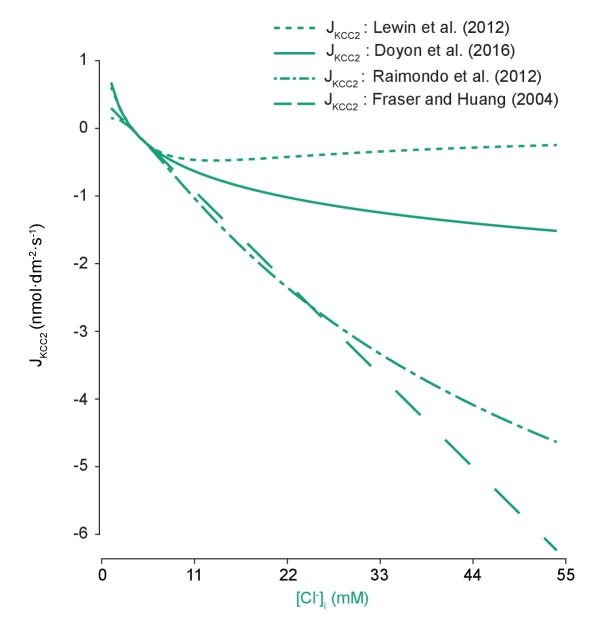
Models of KCC2 have different kinetic properties.The pump rate velocity for different models of KCC2 were compared for differing intracellular chloride concentration. The equation employed in our model was based on Doyon et al. (2016) (solid line) and is described in the main text. Lewin et al. (2012) (dotted line) used the following equation in their computational model:JKCC2=Jscale∙0.3∙[K+]o∙Cl-o-[K+]i∙[Cl-]ikK∙kCl1+[K+]o∙Cl-okK∙kCl1+[K+]ikK1+[Cl-]ikCl+1+[K+]i∙Cl-ikK∙kCl1+[K+]okK1+[Cl-]okCl, where kK=9.0mMandkCl=6.0mM. The model was based on a model of the renal distal tubule (Lewin et al., 2012). Here, it had a diminished absolute velocity compared to our model. The models of Raimondo et al. (2012) and Fraser and Huang (2004) (dashed and dash-dotted lines respectively) had similar velocities across our range of concentrations. Raimondo et al.’s model is based on a model for KCC2 derived using Michaelis-Menton kinetics and experiments, and incorporates new experimental values:JKCC2=Jscale∙Vmax∙Cl-i15mM+Cl-iln⁡[K+]o∙Cl-o[K+]i∙Cl-iln⁡[K+]o∙Cl-o[K+]i∙56mM, where Vmax=5mM∙s-1 (Raimondo et al., 2012). Fraser and Huang based their model on previous experimental evidence (Fraser and Huang, 2004). Their equation for KCC2 follows:JKCC2=Jscale∙PK∙PKCC2[K+]o∙Cl-o-[K+]i∙[Cl-]i, where PK and PKCC2are the permeability constants for potassium and the pump respectively, the latter of which is tuned as needed. Jscale for each model was set such that the same steady state concentrations were achieved using any model with the other parameters kept constant.